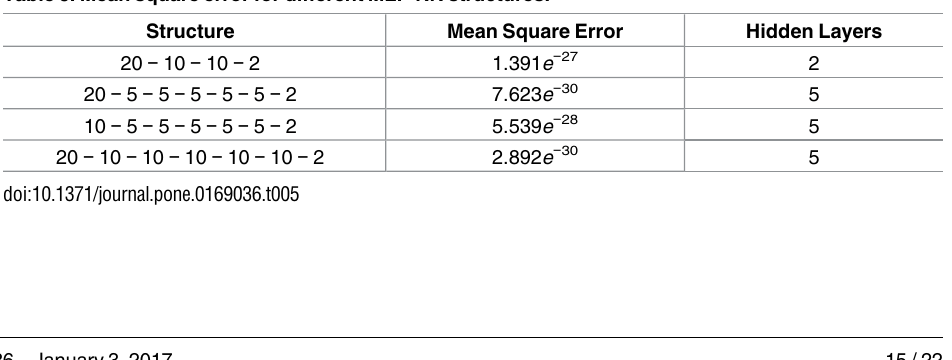
Table 5. Mean square error for different MLF-NN